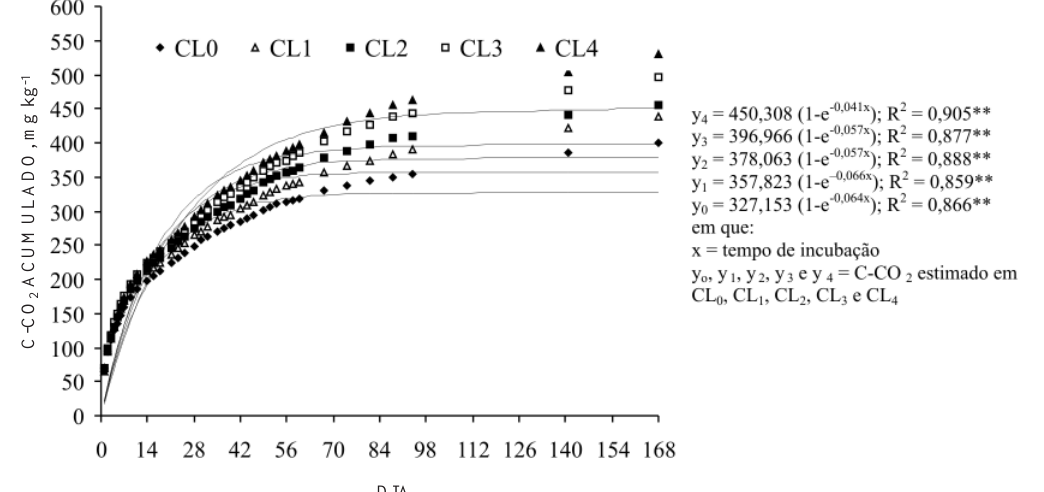
Figura 2. Quantidades acumuladas de C-CO adubado (CL